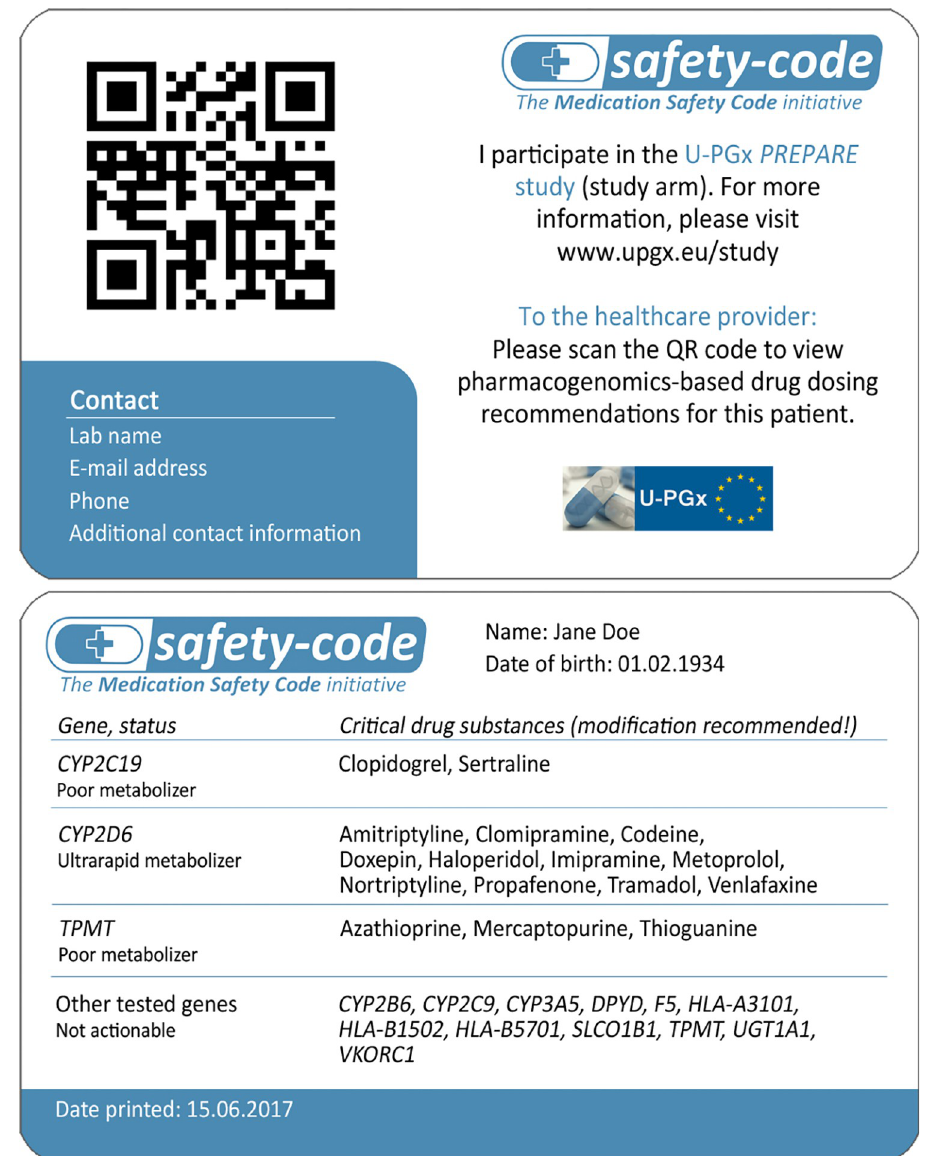
Fig 2. Front and back side of an exemplary Safety Code card for a fictional patient. The Safety Code card is given to all patients recruited for the ‘PGx-guided treatment’ arm of the study. Patients recruited for the control arm were eligible to receive a Safety Code card at the end of the study